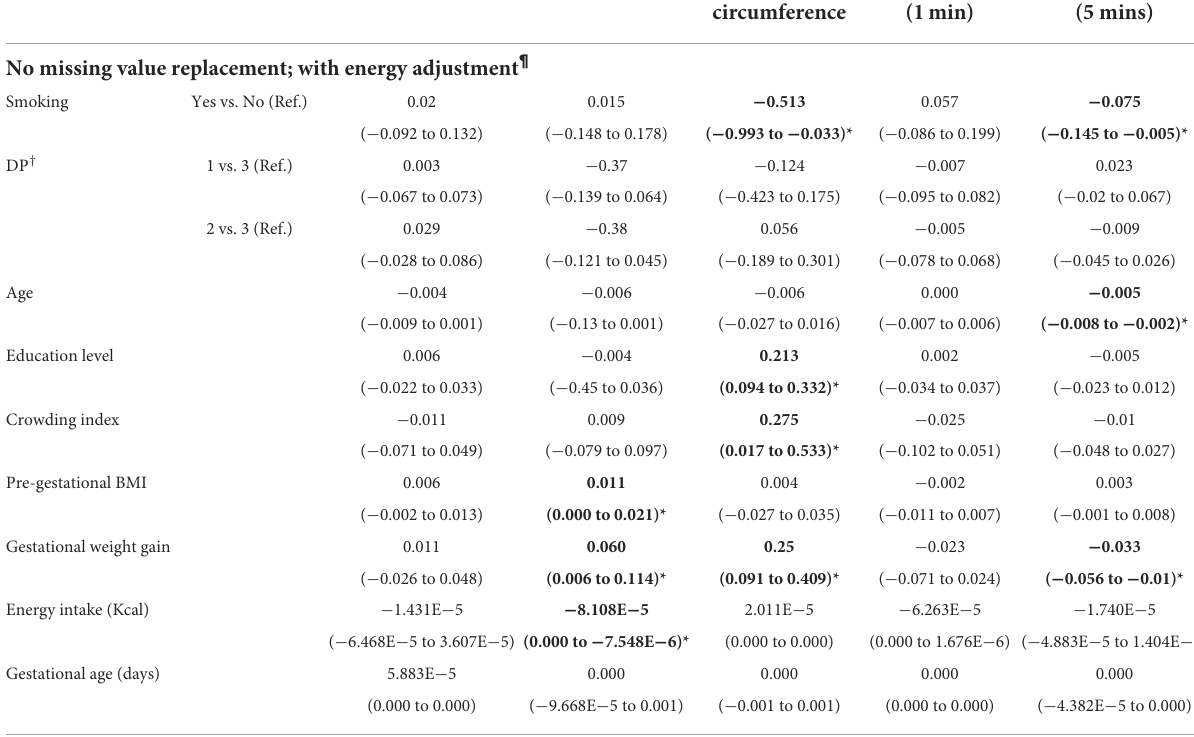
TABLE 9 Multivariate analysis of neonatal